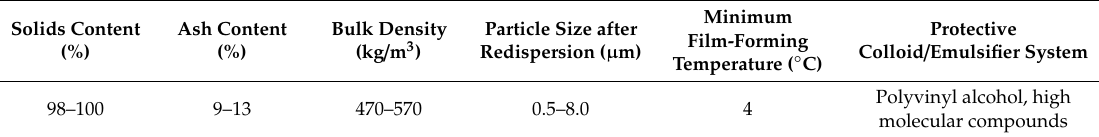
Table 7. Properties of ethylene-vinyl acetate (EVA) powder.